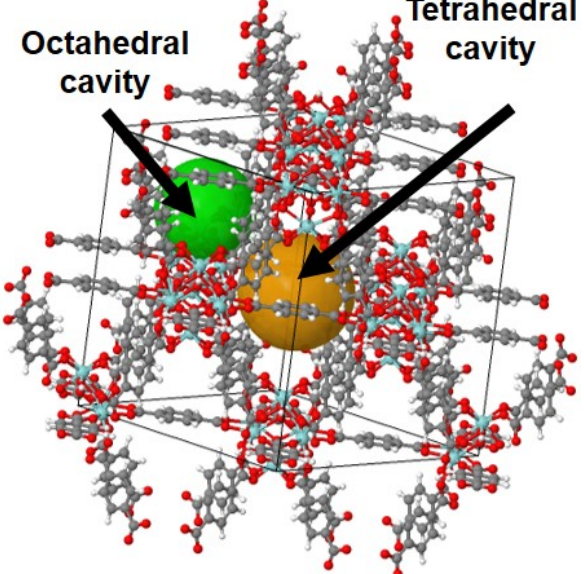
Figure 3. Structure of UiO-66(Zr) showing the carbon (gray), hydrogen (white), oxygen (red), zirconium (blue) and the unit cell (black outline). The tetrahedral and octahedral cavities are indicated by the green and orange spheres. Adapted from [48].